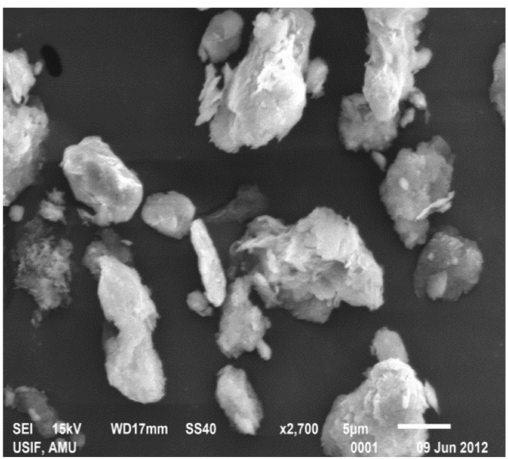
Figure 3. Scanning electron micrographs of bentonite at 2700 magnification